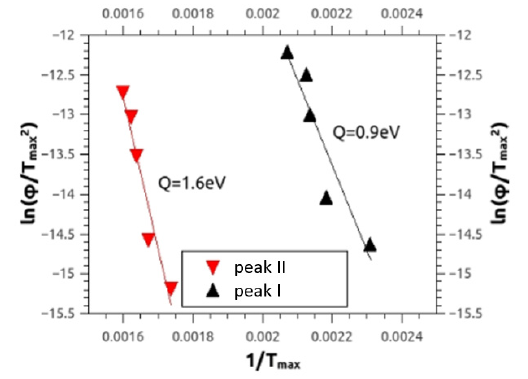
Figure 21. Typical Kissinger plot referring to Equation (4) comprising the peak temperatures T max of peak I and peak II measured by DSC, for HPT ‐ processed Mg5Zn0.15Ca at 4 GPa for 0.5 rotation. The full lines represent the regression to the experimental data; the activation enthalpy Q was calculated from their slopes. Table 6. Measured and calculated data for DSC peak I. ρ is the dislocation density, c v the vacancy concentration.